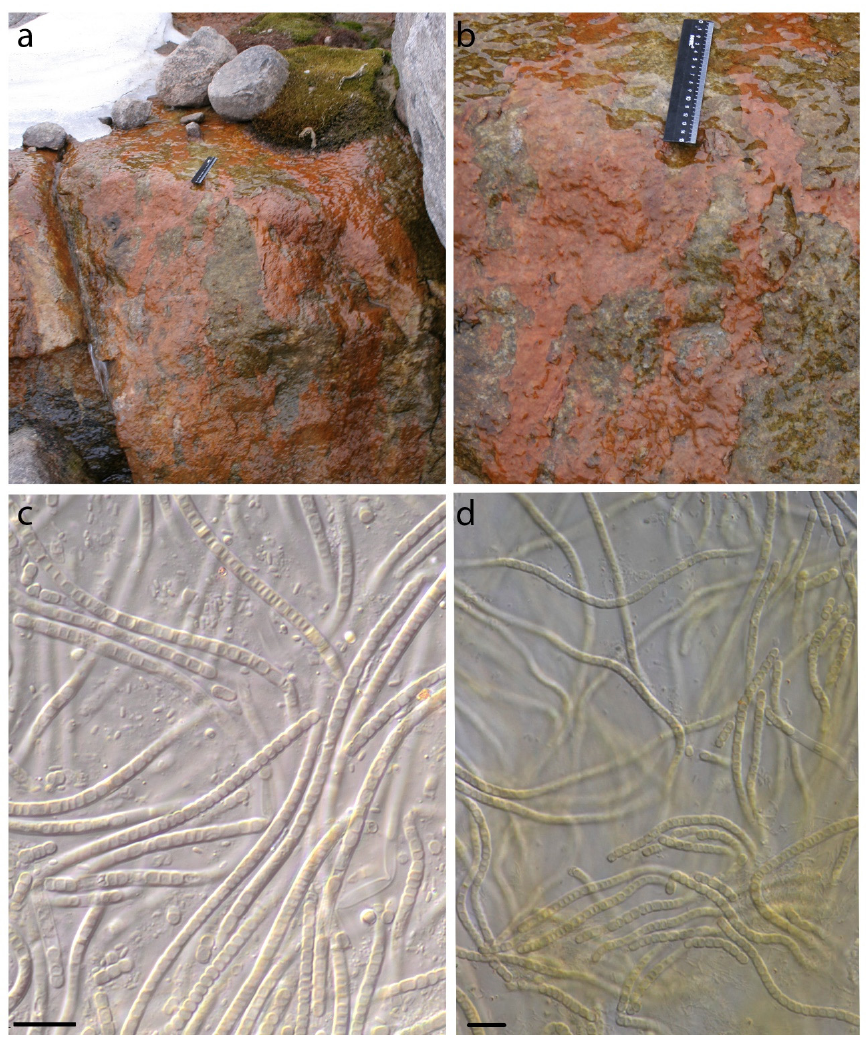
Figure 8. Habitat where Phormidesmis priestleyi was found. ( a , b ) a cyanobacterial mat, ( c , d ) DIC mi- cro-photographs of Phormidesmis priestleyi KPABG 610017. Scale 10 μ m.